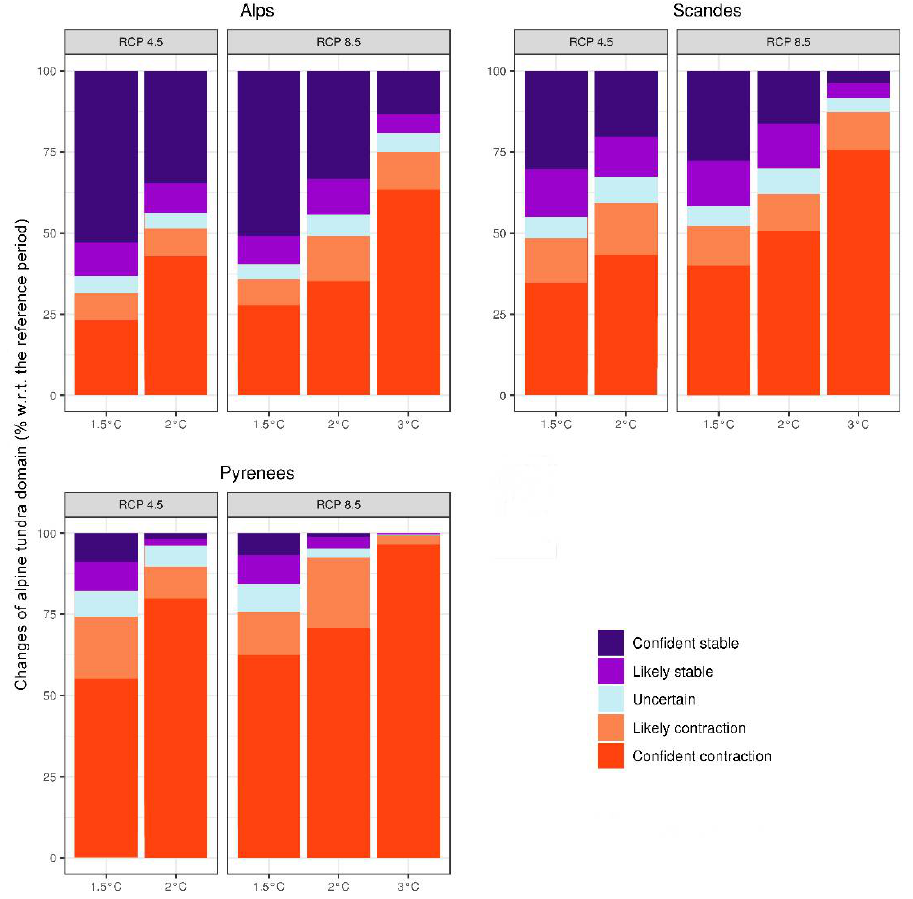
Figure 4. Projected relative area change of the alpine tundra domain (ATD) under scenario RCP4.5 and RCP8.5 in in three warming levels. Changes with respect to the reference period (1981–2010) extent of the ATD in three regions: Alps, Scandes and Pyrenees. Categories in the legend according to Table 2 and description in methods.